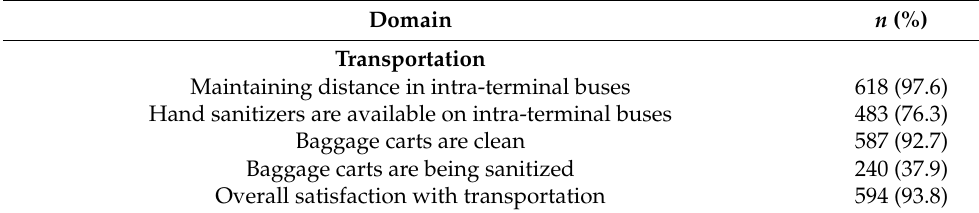
Table 3. In the domain of transportation, the highest number of participants (97.6%) were satisfied with distancing in the intra-terminal buses. Overall satisfaction with transportation was about 94%. The highest satisfaction in the domain of lounges and corridors was about the presence of distance markings (99.7%) and cleanliness (97.7%). While the lowest satisfaction was with the availability of health messages in different languages (26%) and the behavior of travelers about following social distancing at luggage belts (31%). Overall satisfaction with lounges and corridors was 96%. At the counters, the highest satisfaction was with cleanliness (99%) while the lowest was with compliance of people with social distancing (66%). Overall satisfaction with counters was 98%. Concerning airport staff, all (100%) of the participants reported that staff wore masks. Overall satisfaction with airport staff was about 97%. Table 3. Satisfaction of travelers with infection control measures at airports in Saudi Arabia during the COVID-19